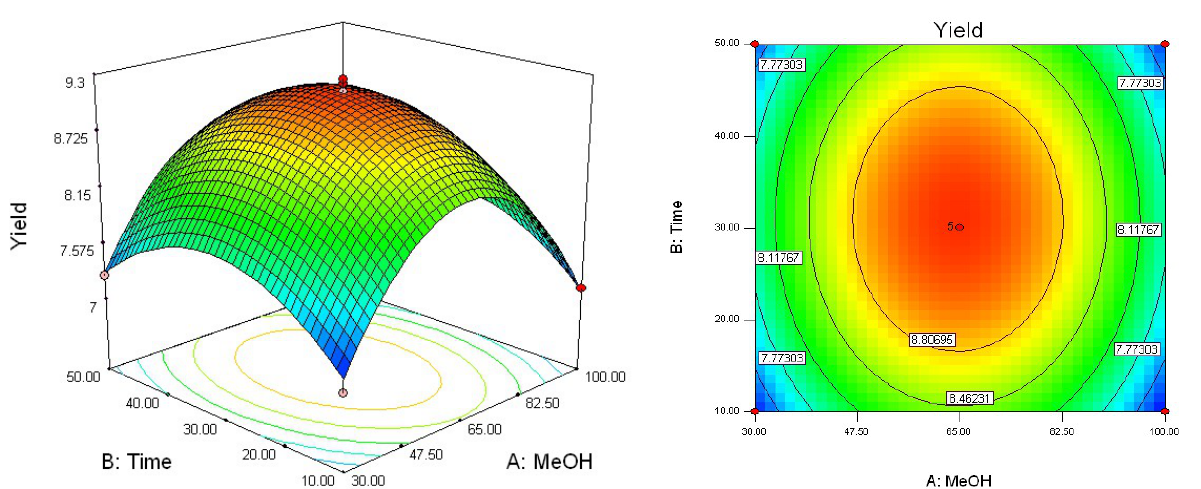
Figure 2. Response surface plot of methanol concentration and extraction time.